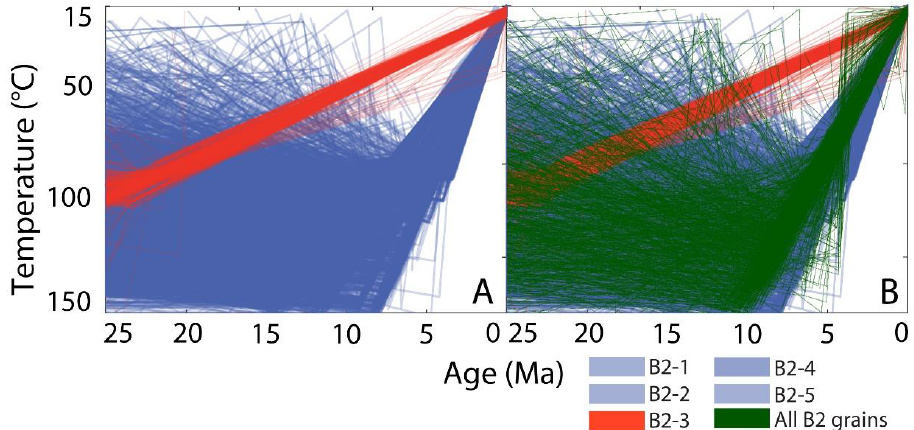
Figure 5. Thermal model results for individual single grain runs from sample B2 of [12] . ( A ) Red represents results for date rejected by [12] . Blue represents dates not rejected by [12] . Results shown as accepted individual time-temperature paths from post “burn in” model iterations. ( B ) Same frame as shown in A with accepted post “burn in” thermal histories from model with all grains run together shown in green.